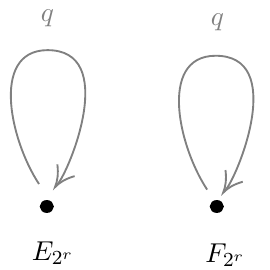
Figure 4 . The E 2 r and F 2 r families of prime abelian TQFTs are invariant under Galois conjugation.